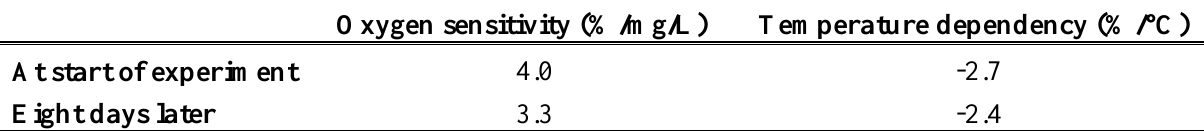
Table 2. Change in oxygen sensitivity and temperature dependency after eight days.